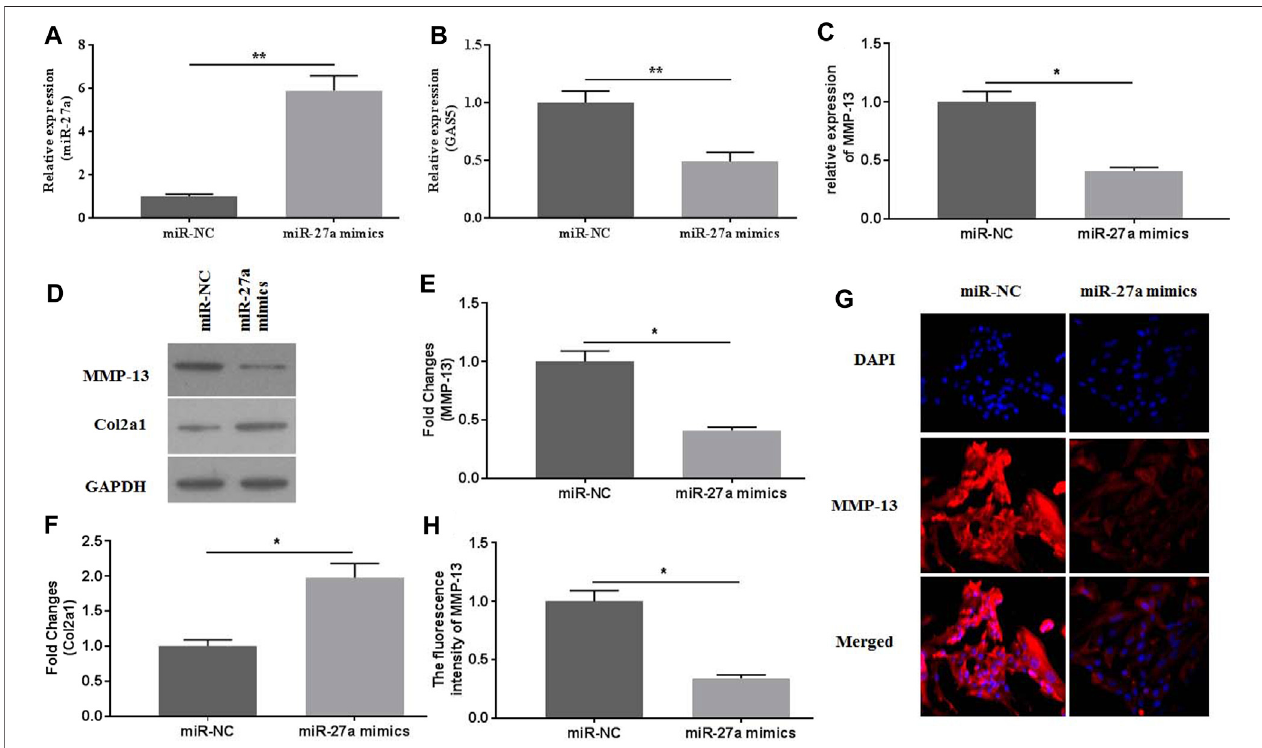
FIGURE 5 | The effects of miR-27a mimic-transfection on mechanical stimulation-induced MMP-13 expression were investigated. The expression of miR-27a (A) and GAS5 (B) wasdetermined byqRT-PCRinmiR-27amimic-transfected chondrocytes. ThemRNA (C) expression ofMMP-13wasdeterminedbyqRT-PCR,and the protein expression of MMP-13 (D-E) and Col2a1 (D and F) were determined by western botting assays. (G) The immuno fl uorescence intensity of MMP-13 was detected. (H) The calculation of fl uorescence activity of MMP-13. * p < 0.05 and ** p < 0.01.